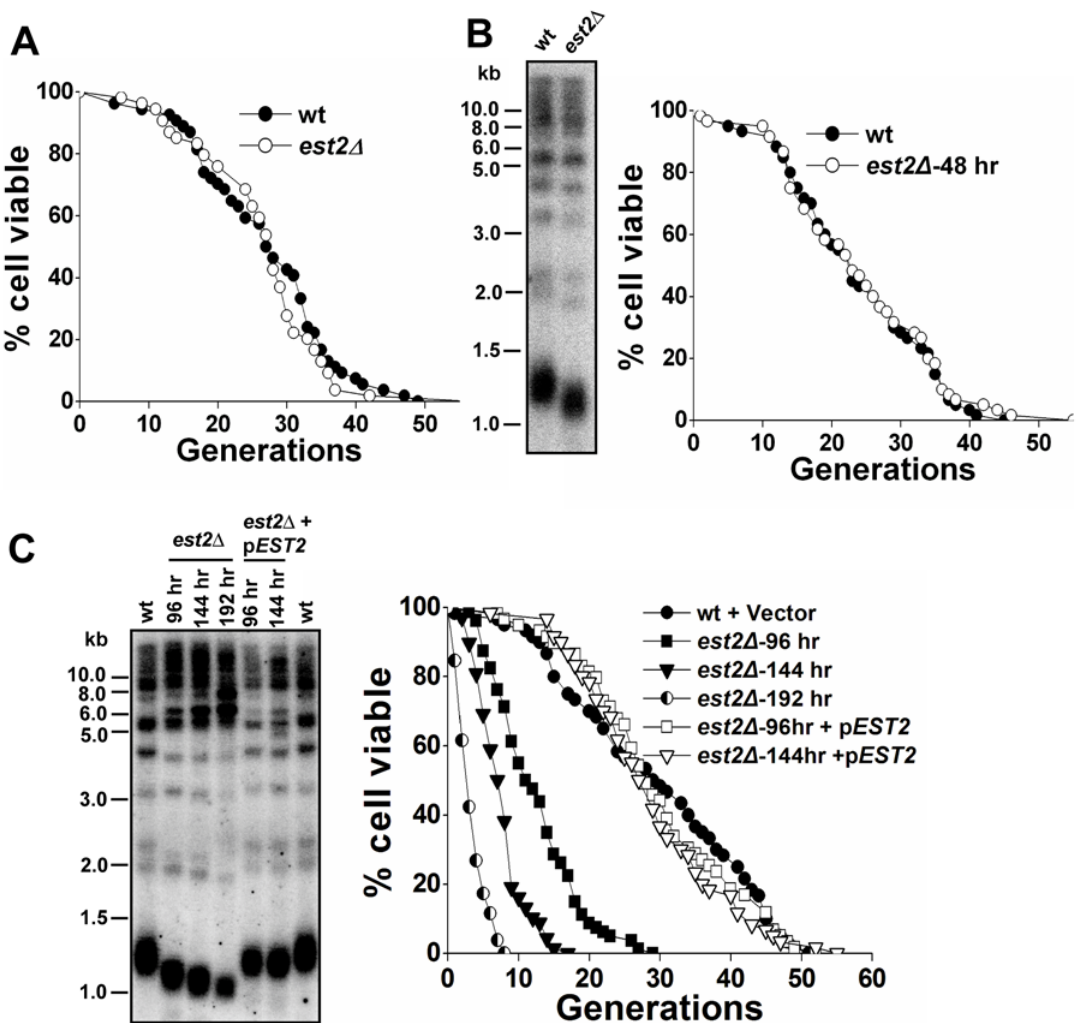
Figure 4. Replicative life span analysis of yeast cells with different telomere length. (A) Life span analysis of spores immediately dissected from BY4743 EST2/est2 ::HIS3 . Average life span of strains shown (sample size): wild-type, 26.6 6 9.1 (n=54); est2 D , 27.0 6 9.9 (n=54). (B) Life span (right) and telomere length (left) of wild-type and est2 D mutants determined 48 hr growth after tetrad dissection. Average life span of strains shown (sample size): wild-type, 23.7 6 10.2 (n=60); est2 D , 24.3 6 11.0 (n=60). (C) Life span (right) and telomere length (left) of est2 D mutants determined 96, 144, or 192 hr growth after tetrad dissection; and the 96 hr, 144 hr passaged est2 D cells after transformed with a functional EST2 CEN plasmid. Average life span of strains shown (sample size): wild-type + Vector, 29.4 6 12.8 (n=60); est2 D -96 hr, 12.5 6 6.0 (n=80); est2 D -144 hr, 7.6 6 3.4 (n=68); est2 D -192 hr, 3.5 6 1.9 (n=52); est2 D -96 hr + EST2 , 29.8 6 10.9 (n=59); est2 D -144 hr + EST2 , 28.7 6 10.2 (n=60).